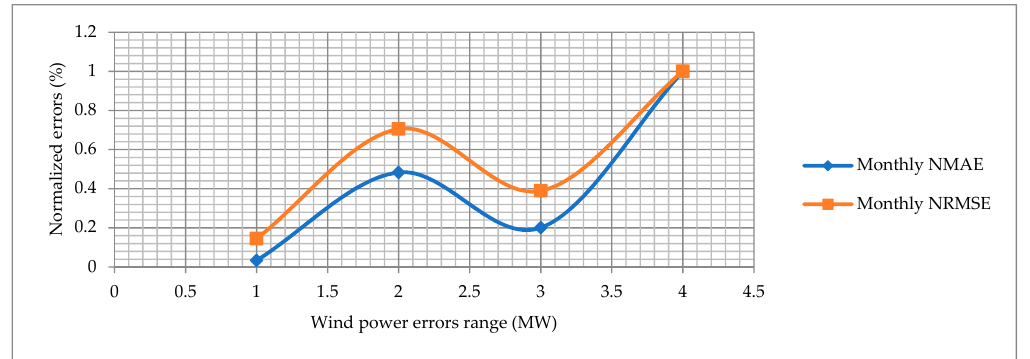
Figure 19. Normalized errors for monthly wind power forecasting.